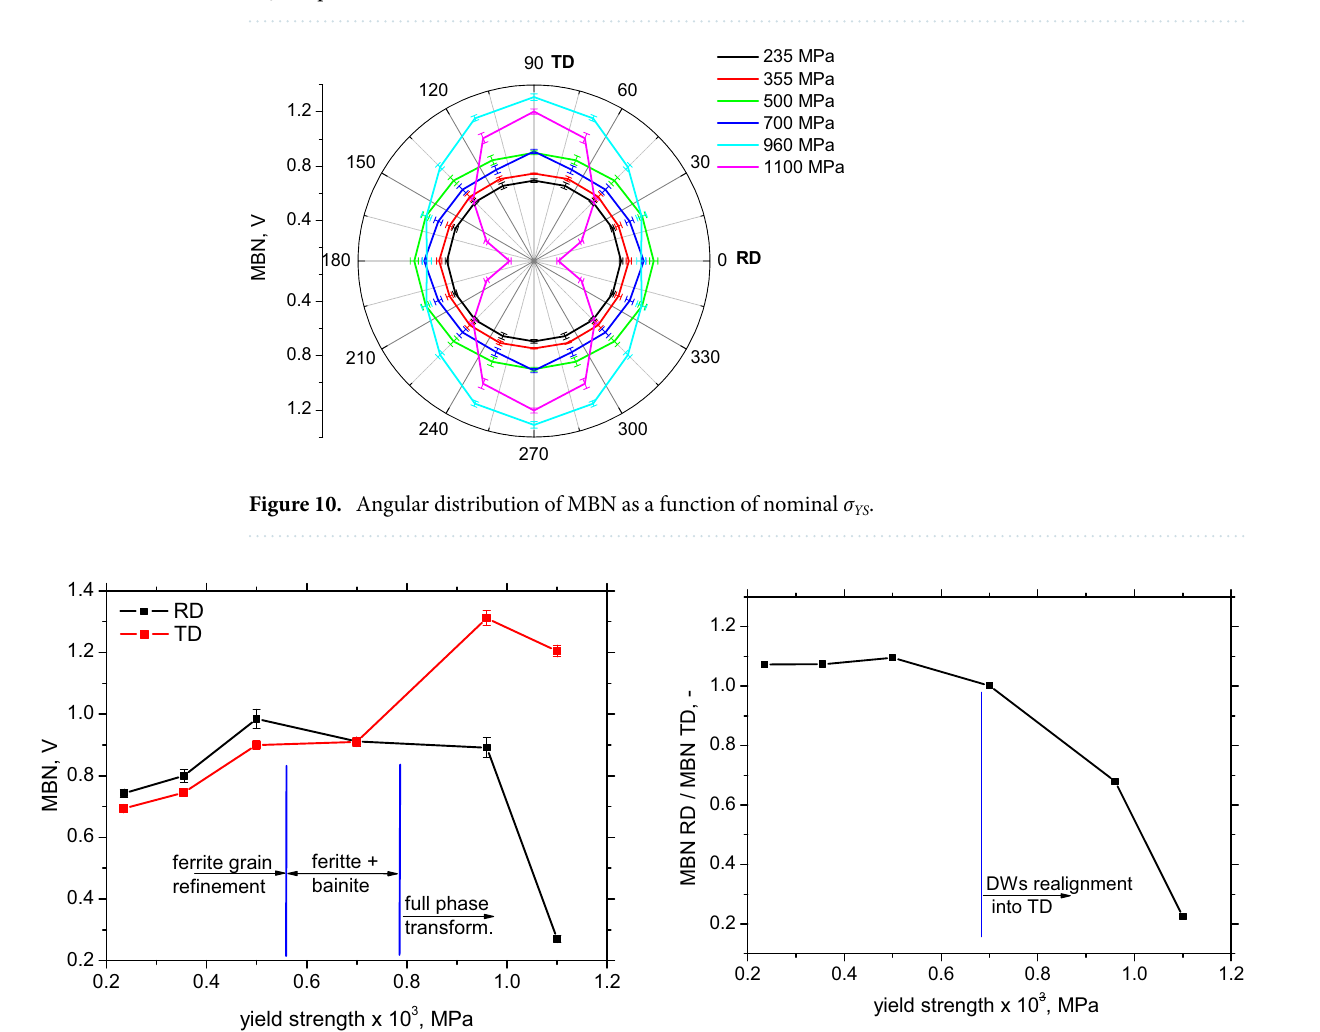
Figure 9. Dependence of reversible and irreversible permeability vs. magnetic field with nominal yield strength σ YS as a parameter.